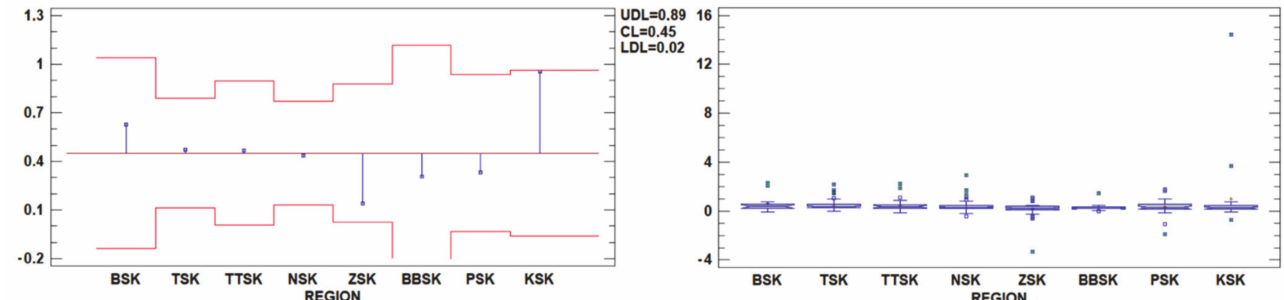
Figure 5. Comparison of the structure of results at the level of individual regions—Taffler model, agricultural cooperatives. Legend: BSK—Bratislava region, TSK—Trnava region, TTSK—Trenˇc í n region, NSK—Nitra region, ZSK—Žilina region, BBSK—Bansk á Bystrica region, PSK—Prešov region, KSK—Košice region; UDL—upper decision limit, CL—central line, LDL—lower decision limit.